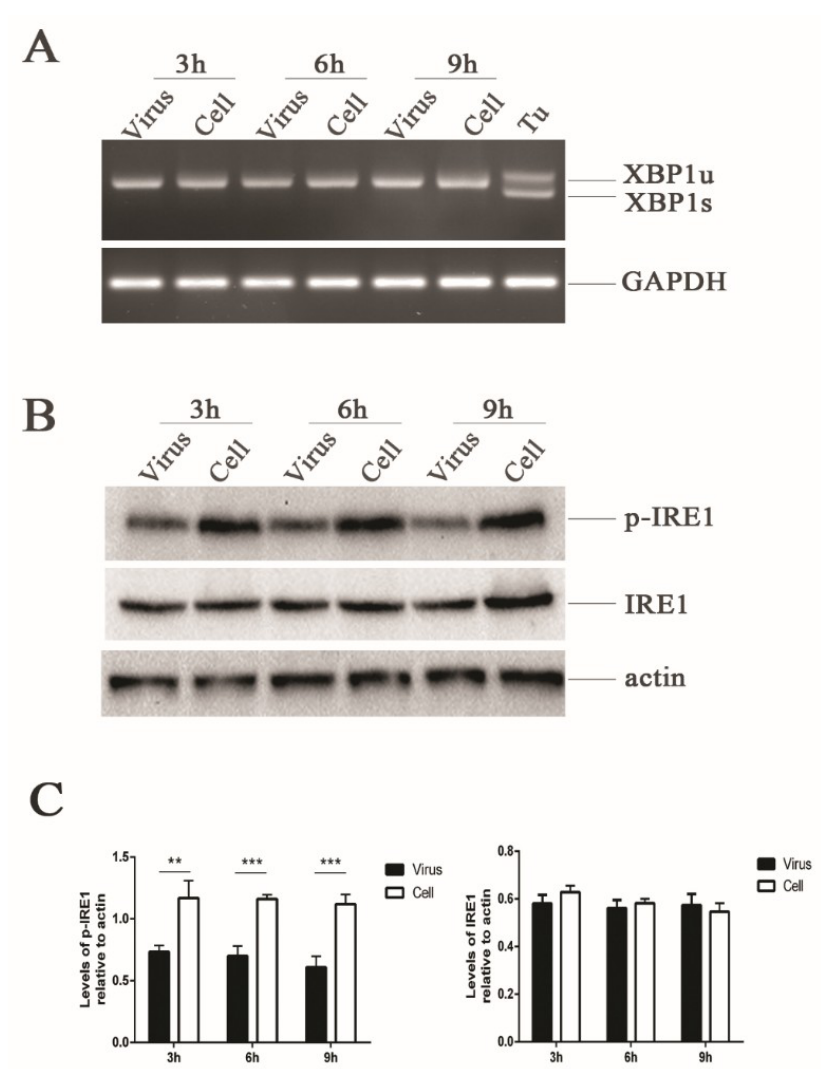
Figure 2. HRV16 infection induces dephosphorylation of IRE1. ( A ) Total RNA was extracted from cells after H1-HeLa cells were infected with HRV16 (MOI = 5) for 3 h, 6 h and 9 h. The expression of XBP1 at the mRNA level was detected by RT-PCR. Cells treated with 1.0 µ g/mL tunicamycin were used as a positive control. ( B ) The expressions of p-IRE1, IRE1 and actin were detected in H1-HeLa cells infected with HRV16 (MOI = 5) for 3 h, 6 h and 9 h by Western blotting. Uninfected cells were used as controls. ( C ) Histograms of gray scanning analyses of the p-IRE1 and IRE1 protein bands of ( B ) relative to actin are shown. The error bars represent the mean SD of three independent experiments. Statistical differences compared with the controls are illustrated as * p < 0.05, ** p < 0.01, and *** p < 0.001.